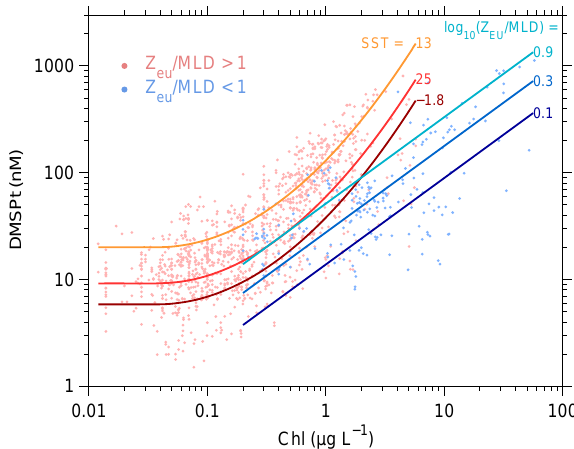
Figure A1. DMSPt SAT sub-algorithm. Dots in the background show database measurements, and lines represent fits for “stratified” and “mixed” conditions at different SST and Z eu / MLD ratios, re-